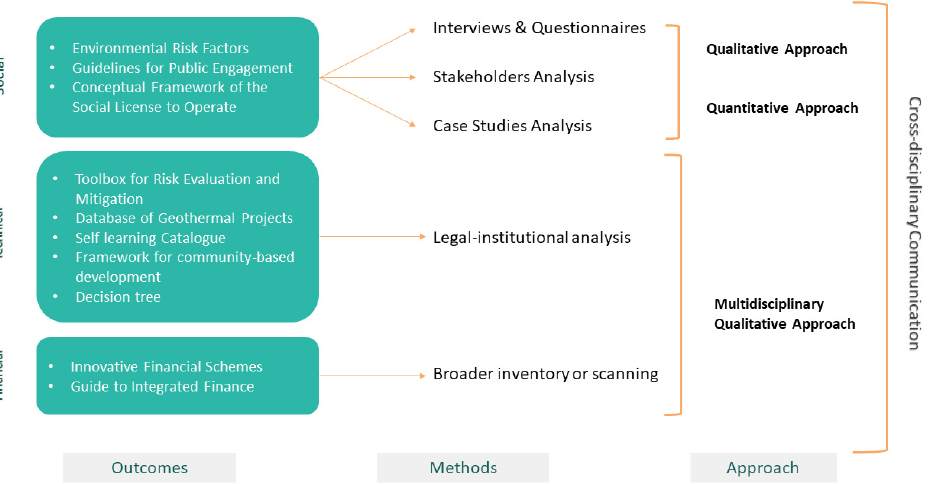
Figure 4. CROWDTHERMAL project methodology Figure 4 . CROWDTHERMAL project methodology approach.